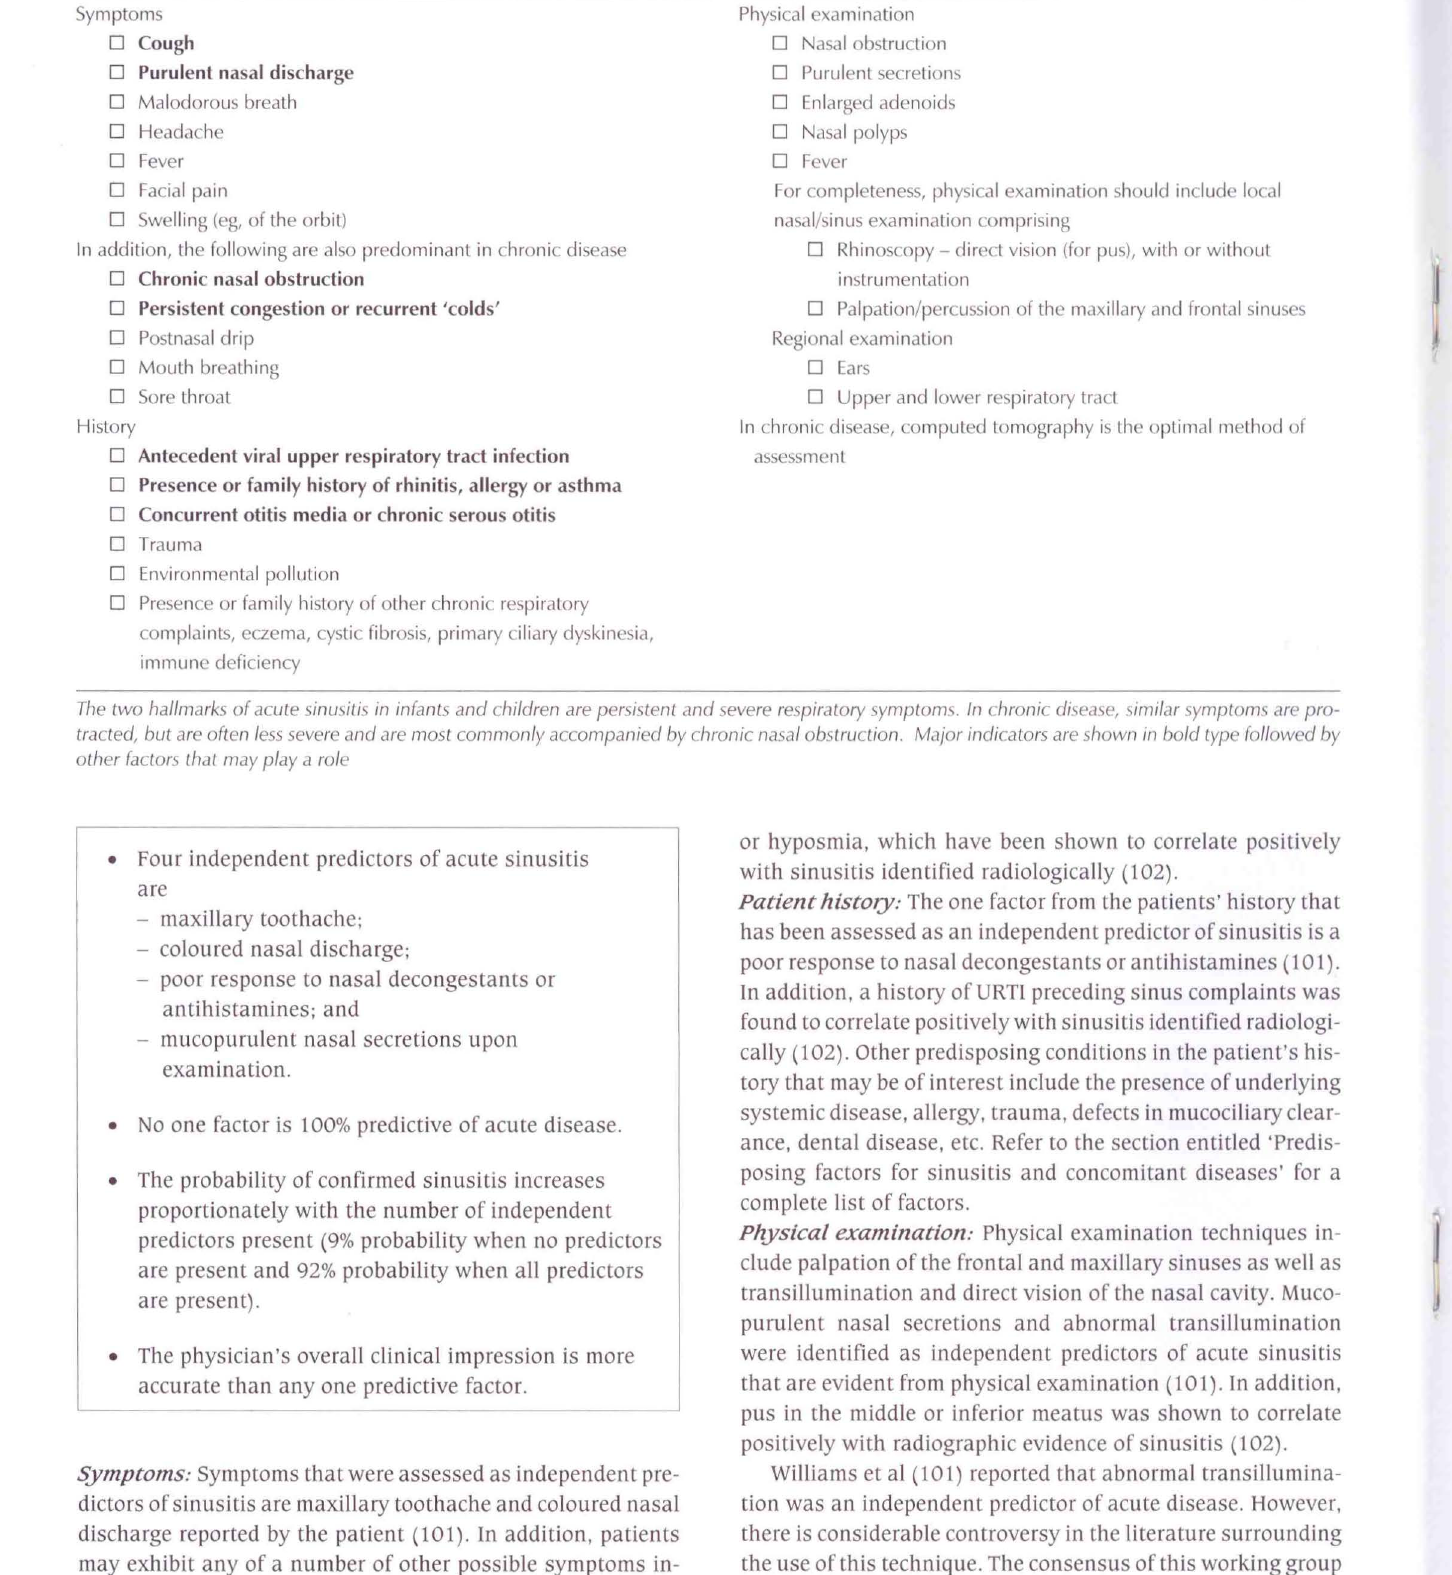
Checklist for diagnosis of paediatric sinusitis in the primary care setting